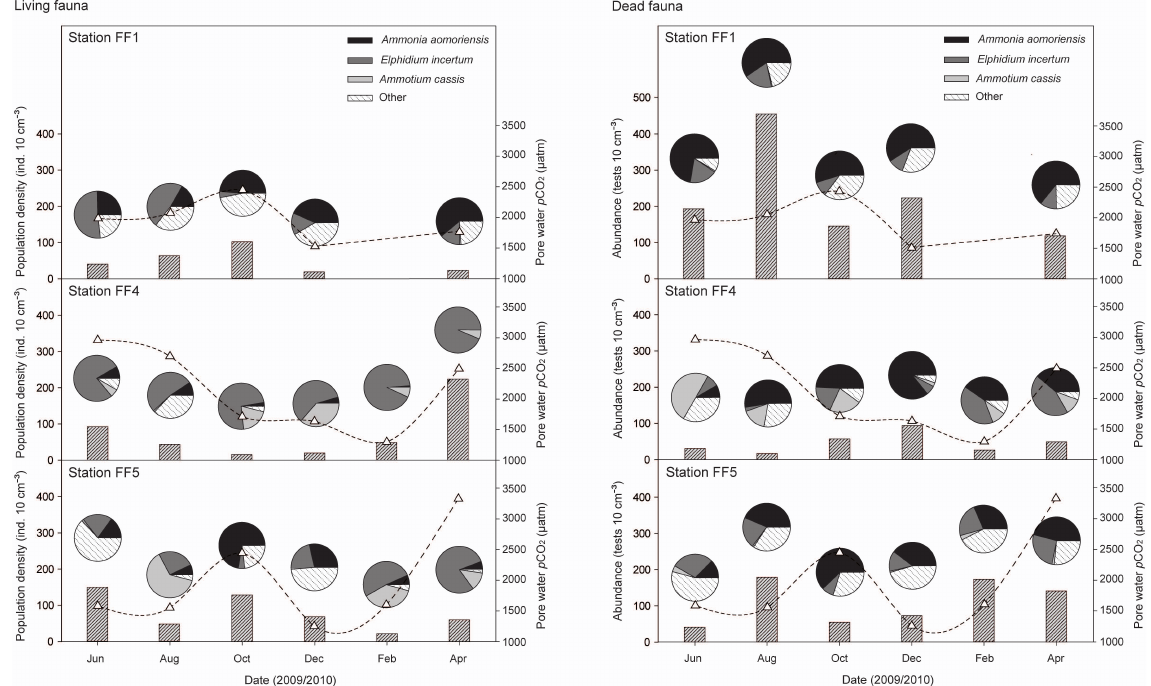
Fig. 4. Proportions and abundance of living and dead benthic foraminiferal species at stations FF1, FF4 and FF5 from June 2009 to April 2010. The bars present the population density and abundance of the living and dead fauna. Pie charts indicate the percentages of dominant species (Tables 5 and 6). Sediment pore water p CO 2 in Flensburg Fjord is displayed by white triangles.